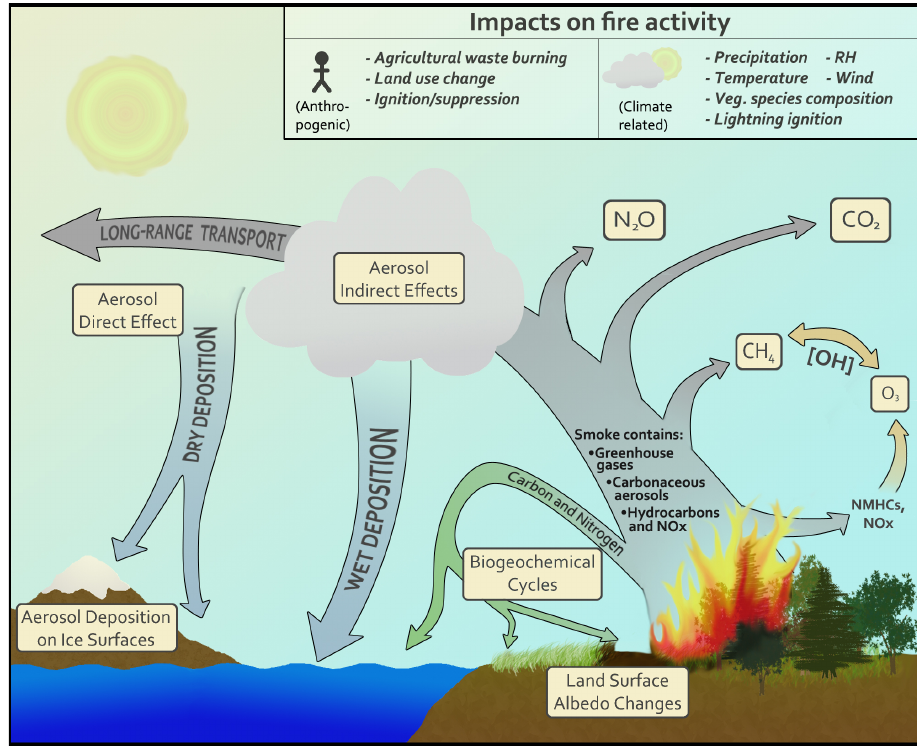
Fig. 1. A schematic illustrating the various impacts of fire on the atmosphere, land surface, ice surfaces and the ocean. 5